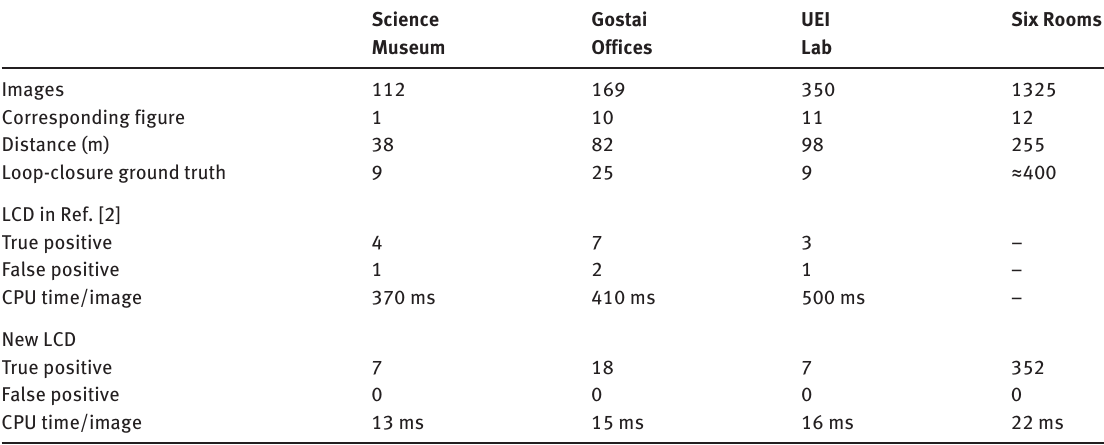
Table 1. Compared Results of the Loop-Closure Detection System Presented in Ref. [2] and the Approach Presented in This Article on Four Sequences.